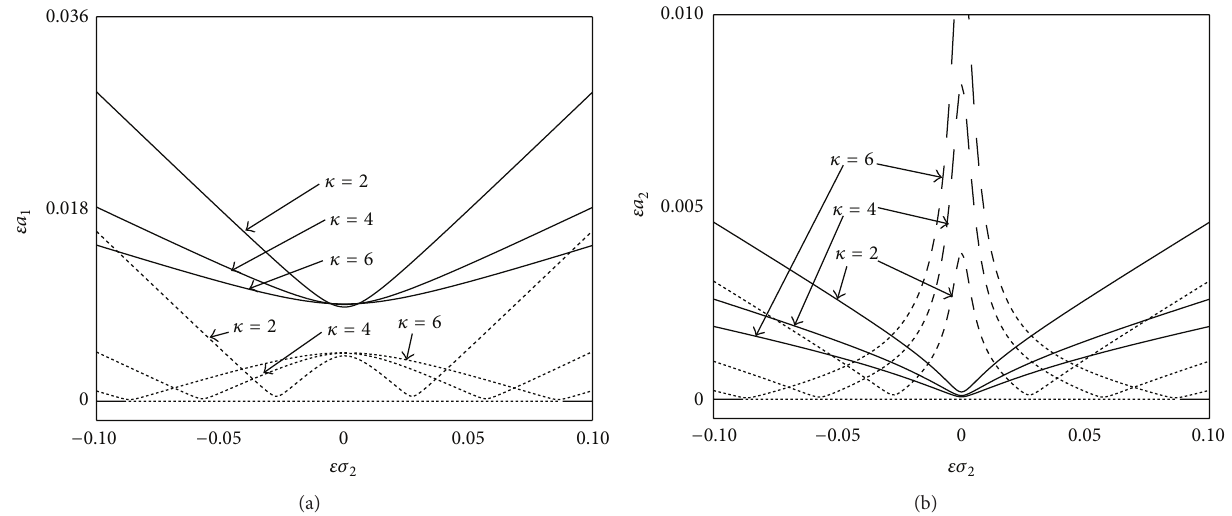
Figure 12: Amplitude-frequency curves of the summation resonance for different nonlinearity: (a) the first-mode and (b) the second-mode coefficients.